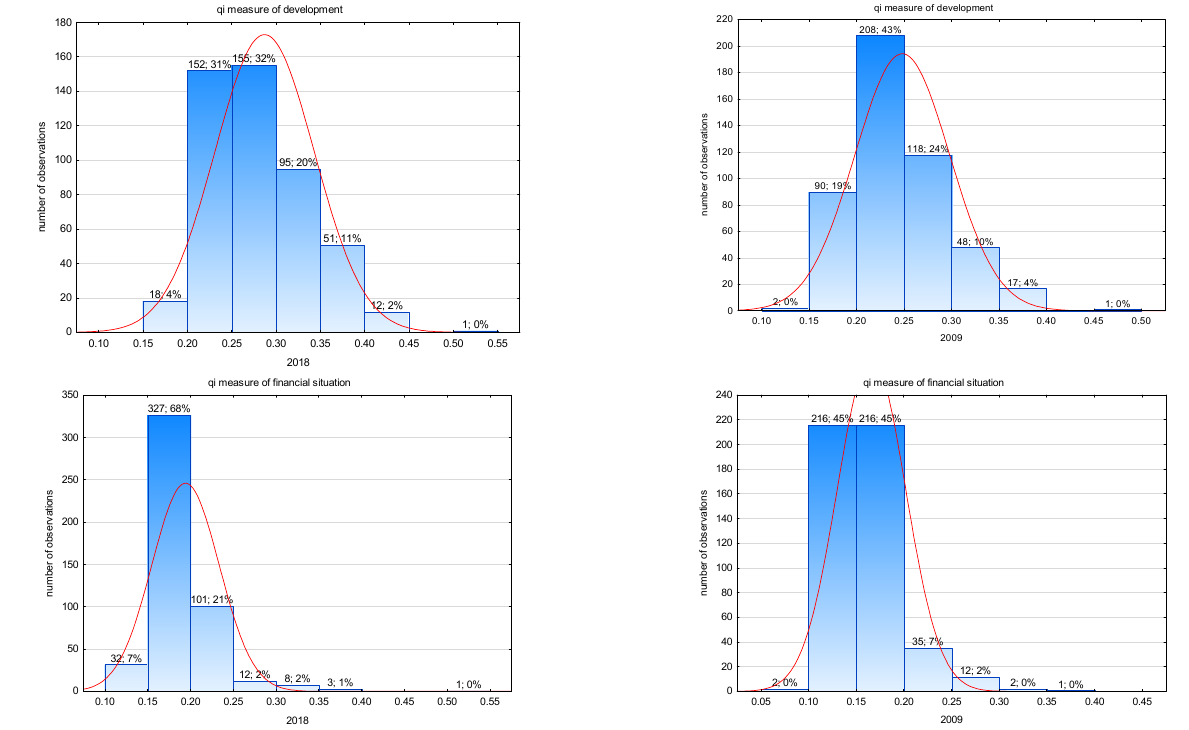
Figure 2. The synthetic measure of the financial situation of rural communes in eastern Poland in 2009 and 2018. Source: own research. Table 4. Statistical characteristics of the synthetic measure of the financial situation of rural communes in eastern Poland in 2009 and